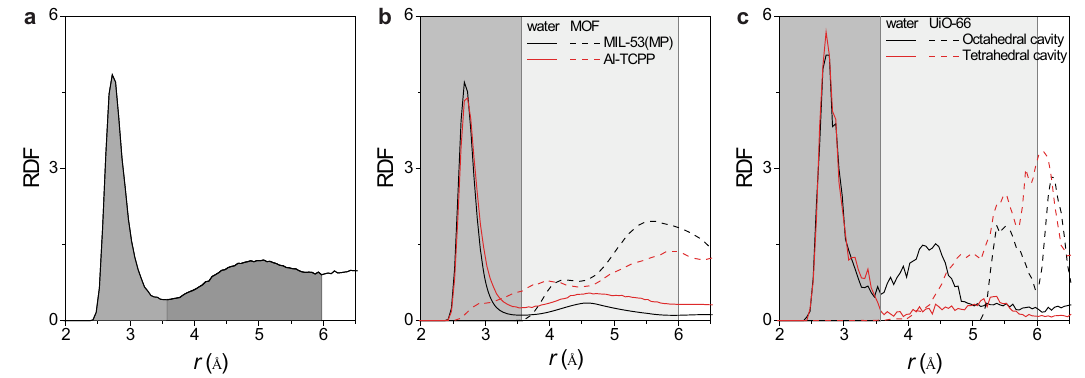
Fig.6|Radialdistributionfunction(RDF)pro fi lesofK+ioninbulksolutionand MOF channels. a The RDF pro fi le for K + -(OH 2 ) in 1.0M KCl solution. The grey and darkgreyregionsmarkthe fi rstandsecondhydrationshellstructures. b , c TheRDF of K + in MIL-53(MP), Al-TCPP, and UiO-66 channels. Note thatthe solid and dashed